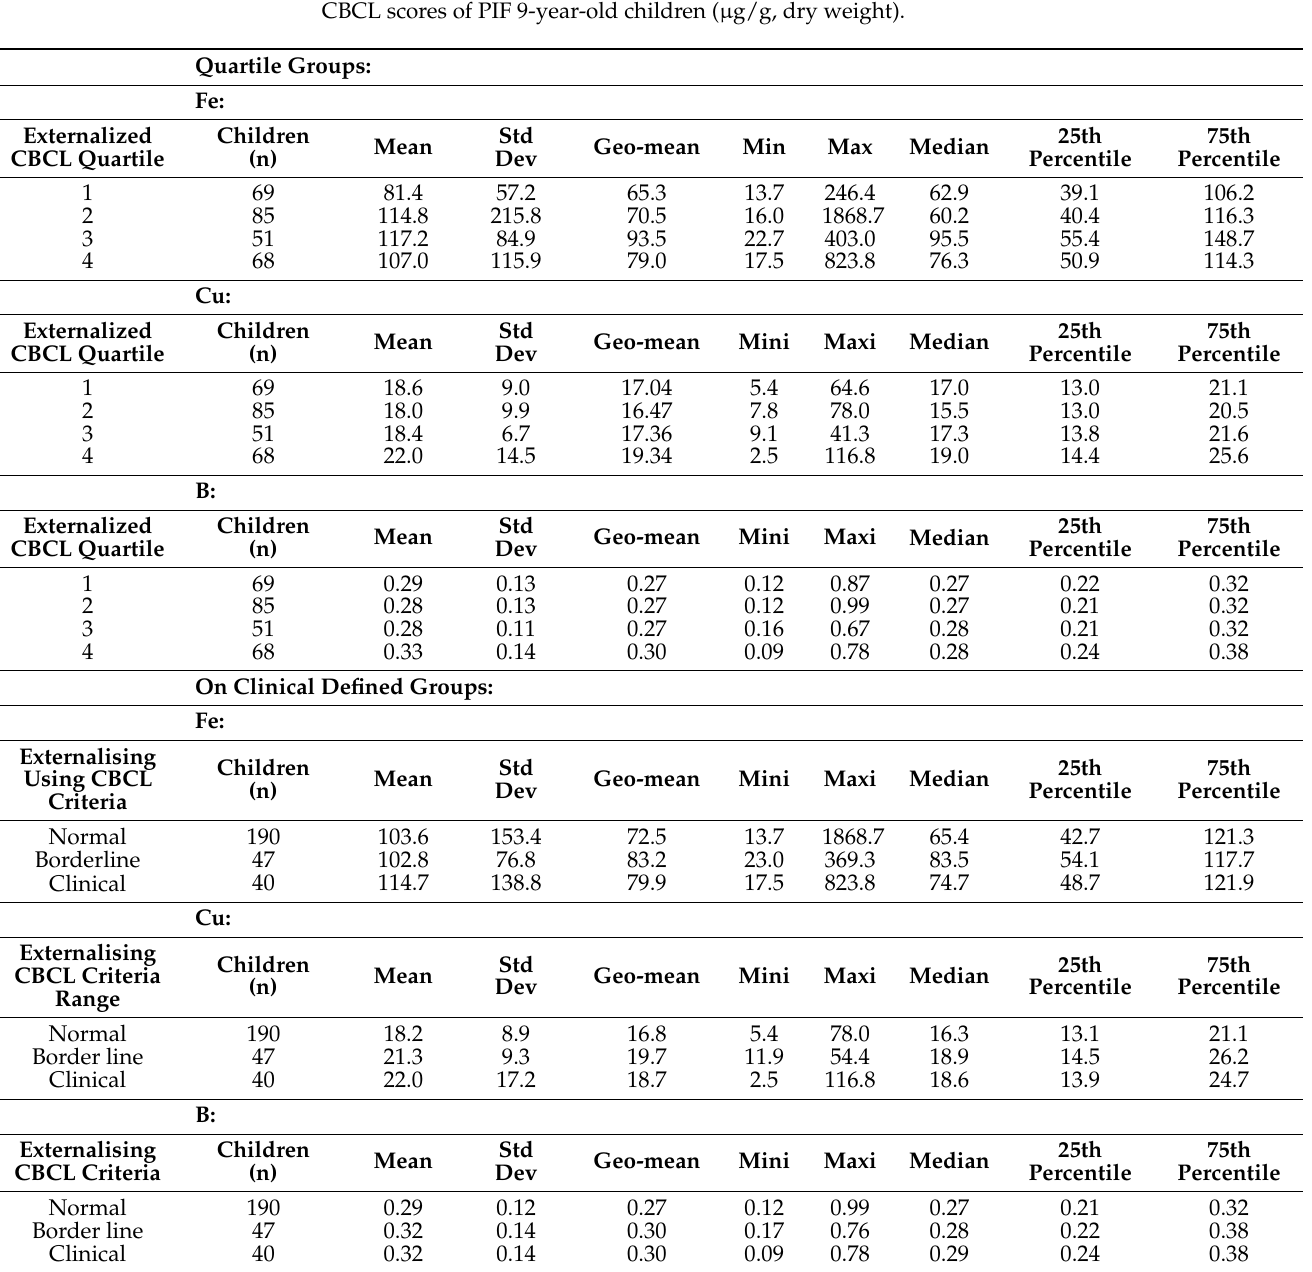
Table 2. Distribution of Fe, Cu, and boron by quartile and clinical defined group of externalizing CBCL scores of PIF 9-year-old children ( µ g/g, dry